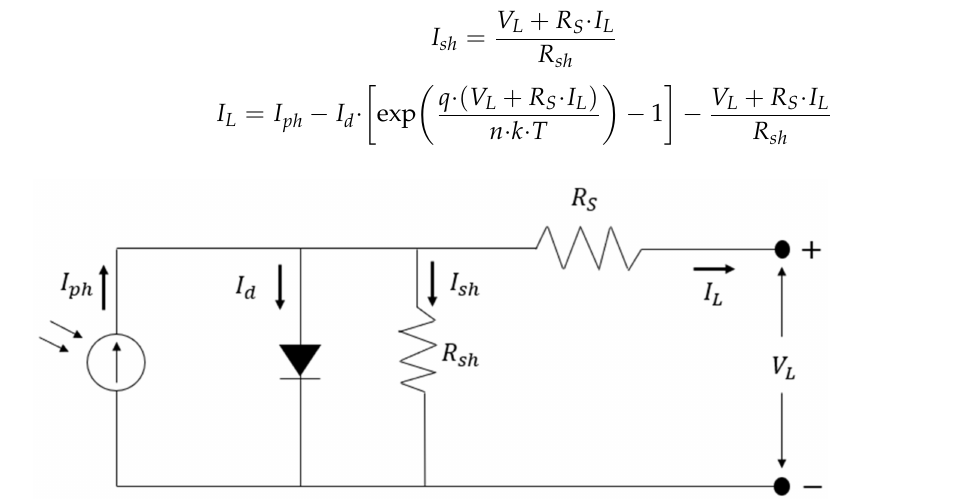
Figure 1. The equivalent circuit of SDM.